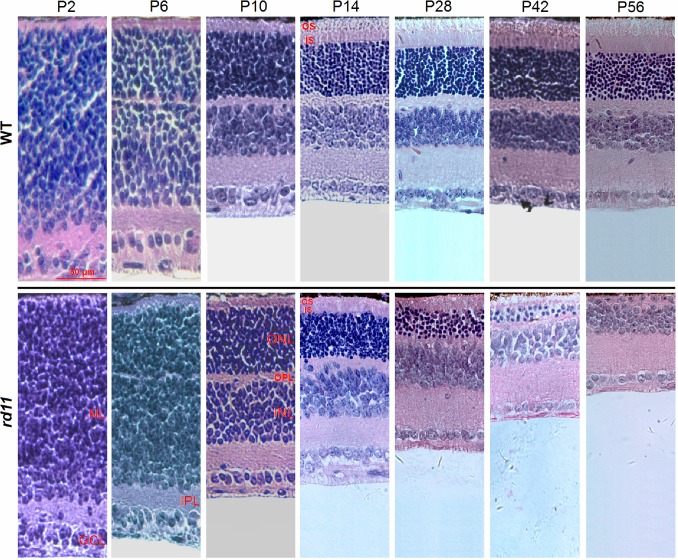
Light microscopy of developing mouse retina after birth.The Lpcat1 deficient rd11 (lower row) and WT C57BL/6J retinas (upper row) had similar shape and thickness from P2 to P14. The ONL was completely differentiated from the NL at approximately P10. In WT retinas, the OS reached mature length with loose discs attached to the RPE at approximately P14. After P14, the thickness of the rd11 retina was markedly reduced due to RD. Age-matched WT C57BL/6J mice were used as controls. NL, neuroblastic layer; GCL, ganglion cell layer; IPL, inner plexiform layer; ONL, outer nuclear layer; OPL, outer plexiform layer; INL, inner nuclear layer; IS, inner segments; OS, outer segments; P, postnatal day; WT, wild-type.